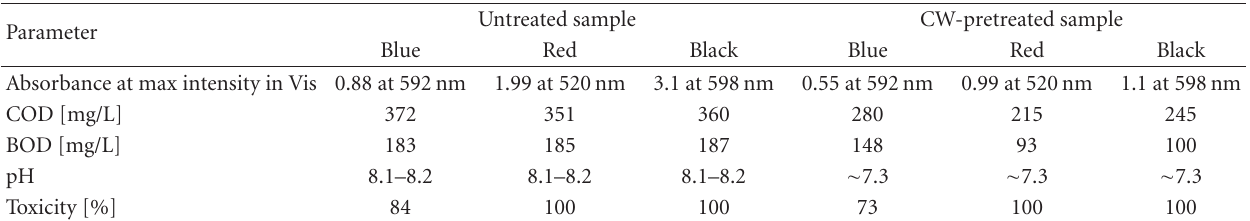
Toxicity [%] 84 100